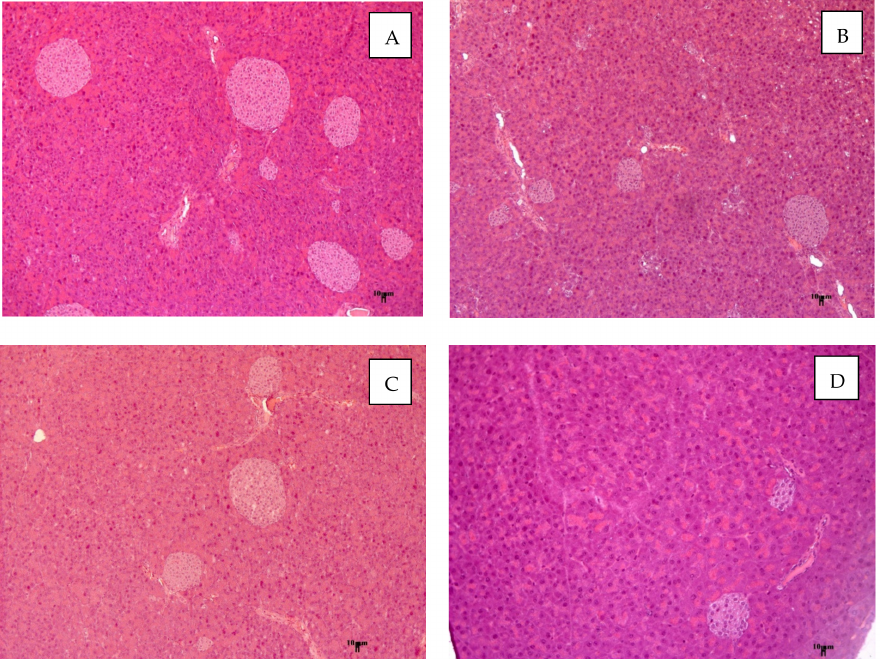
Figure 6. Histological evaluation of pancreas in mice after 4 weeks of experiment. ( A ) AY mice (un- treated), ( B ) AY mice treated by metformin at a dose of 250 mg/kg, ( C ) AY mice treated by compound 2e at a dose of 15 mg/kg, ( D ) C57Bl/6 (healthy control). Hematoxylin and eosin staining, × 100.